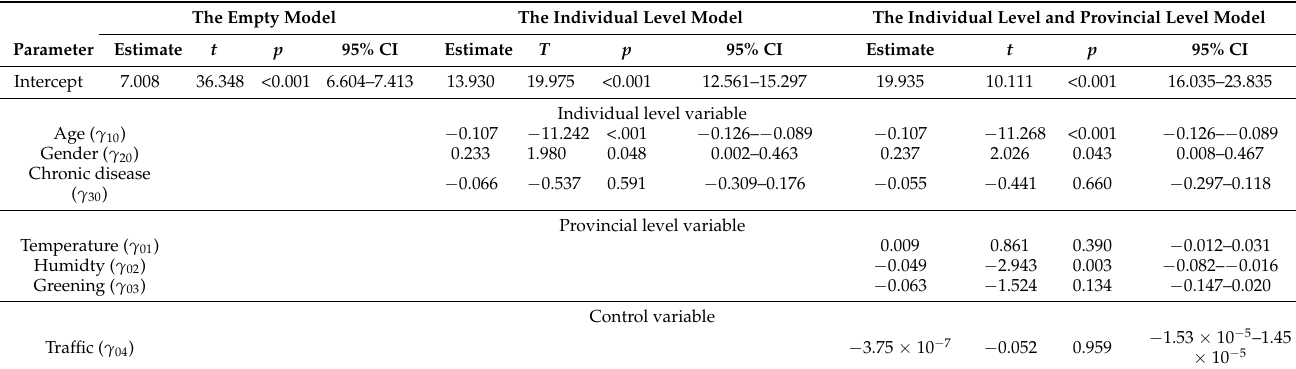
Table 4. The main effects of the empty, individual level, and provincial level